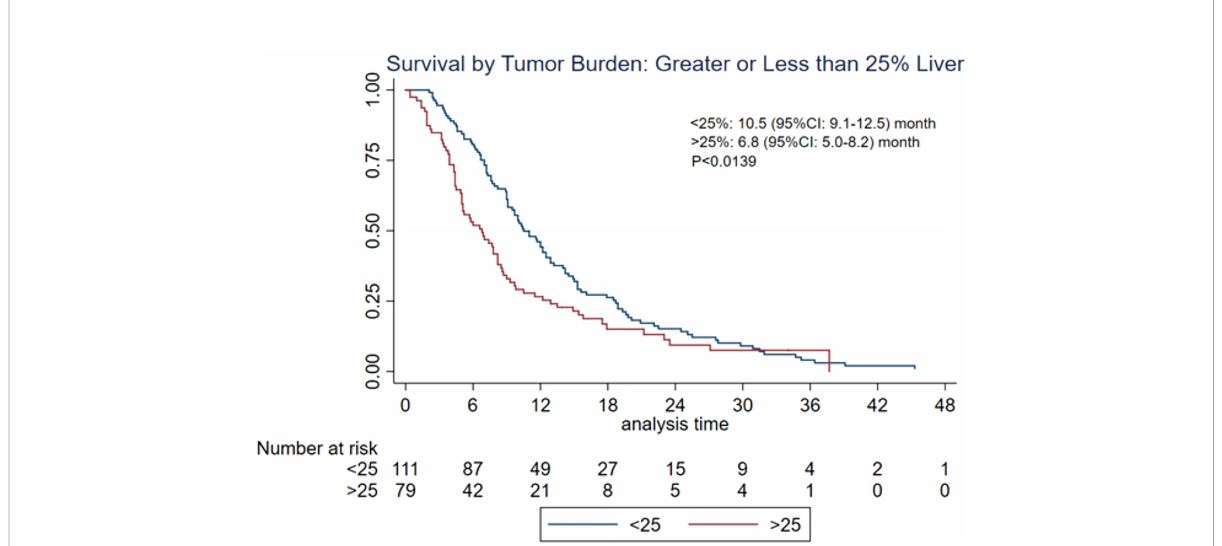
FIGURE 3 Overall survival based on hepatic tumor burden. CI, con fi dence interval; MST, median survival